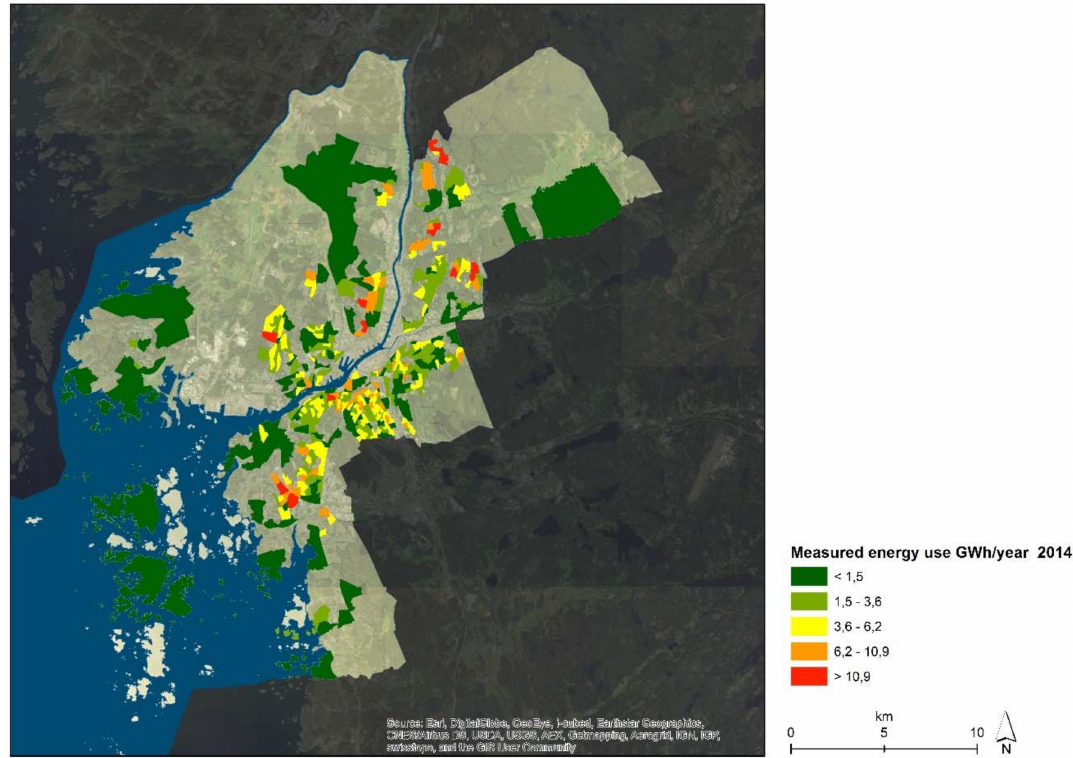
Figure 3. Measured energy use in the building stock aggregated to base areas.